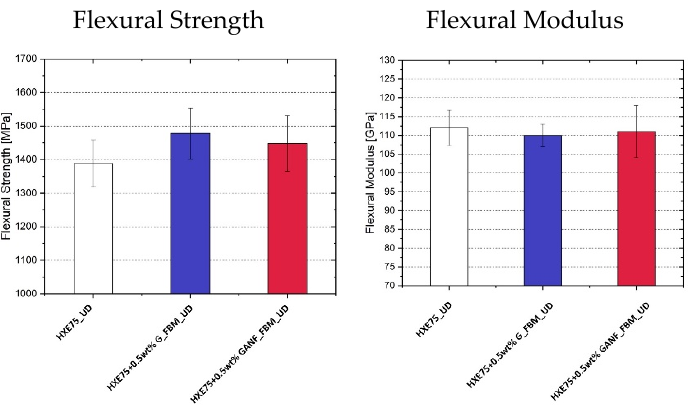
Figure 11. Flexural test results of the composites under examination.